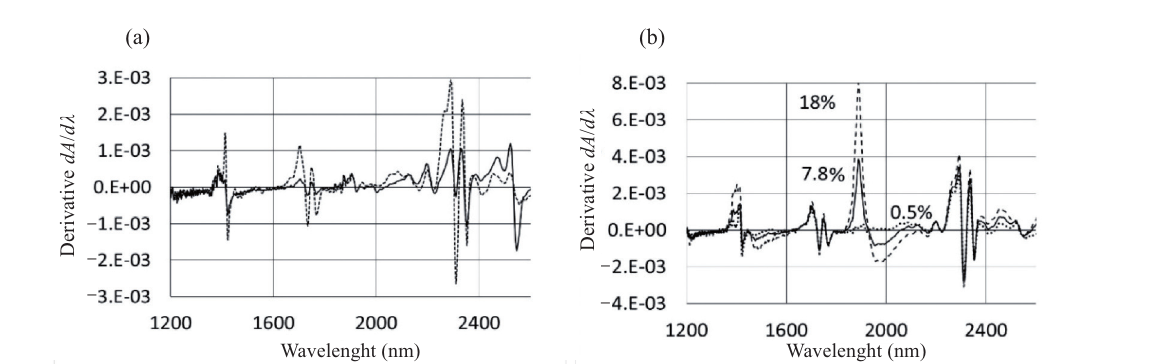
Fig. 3. (a) spectra of dry samples, W ( Q d = 0.5 MJ/kg). (b) spectra of sample A+A´ at three different values of W